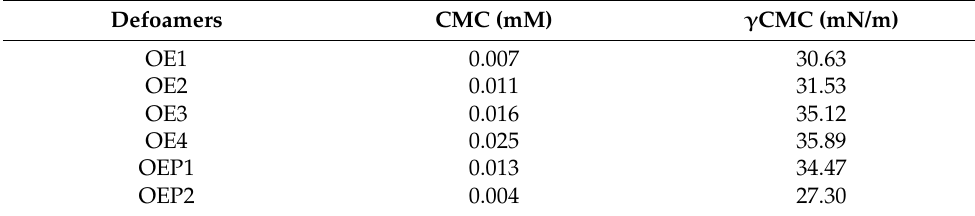
Figure 4. Plot of the changes in surface tension vs. the logarithm of the defoamer concentration. Table 2. Surface activity parameters of the solutions mixed with various defoamers.